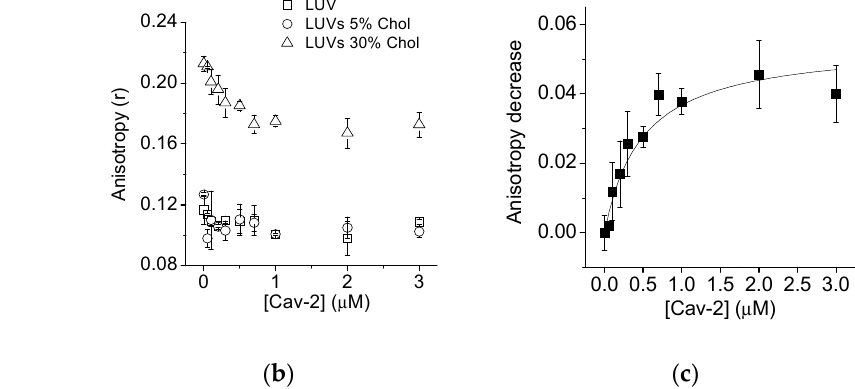
Figure 5. Steady-state anisotropy experiments. (Panel a ): Dependence of the anisotropy of Cav-2 tryptophan fluorescence (excitation and emission wavelength of 280 nm and 340 nm, respectively) upon the concentration of Cav-2 in the presence of PC-LUVs and PC-LUVs supplemented with 30% of cholesterol. (Panel b ): dependence upon Cav-2 concentration of the steady-state anisotropy of DPH incorporated into LUVs supplemented with different cholesterol concentrations: 0% (open squares), 5% (open circles), and 30% (open triangles). The measurements of DPH fluorescence anisotropy were performed with excitation and emission wavelengths of 354 and 452 nm, respectively, in sodium phosphate buffer 25 mM (pH 7.0) in a 2 mL quartz cuvette of 1 cm path length and using a Perkin – Elmer 650-40 with polarizers in parallel and perpendicular positions. (Panel c ): Decrease in DPH anisotropy induced by Cav-2 in LUVs with 30% cholesterol and data fitting to a hyperbolic equation y = P1. x/(Kd + x), where P1 is the maximum binding of caveolin at saturation, × is the concentration of Cav-2, and Kd the dissociation constant. This figure shows the average of experiments performed by triplicate ± S.D.